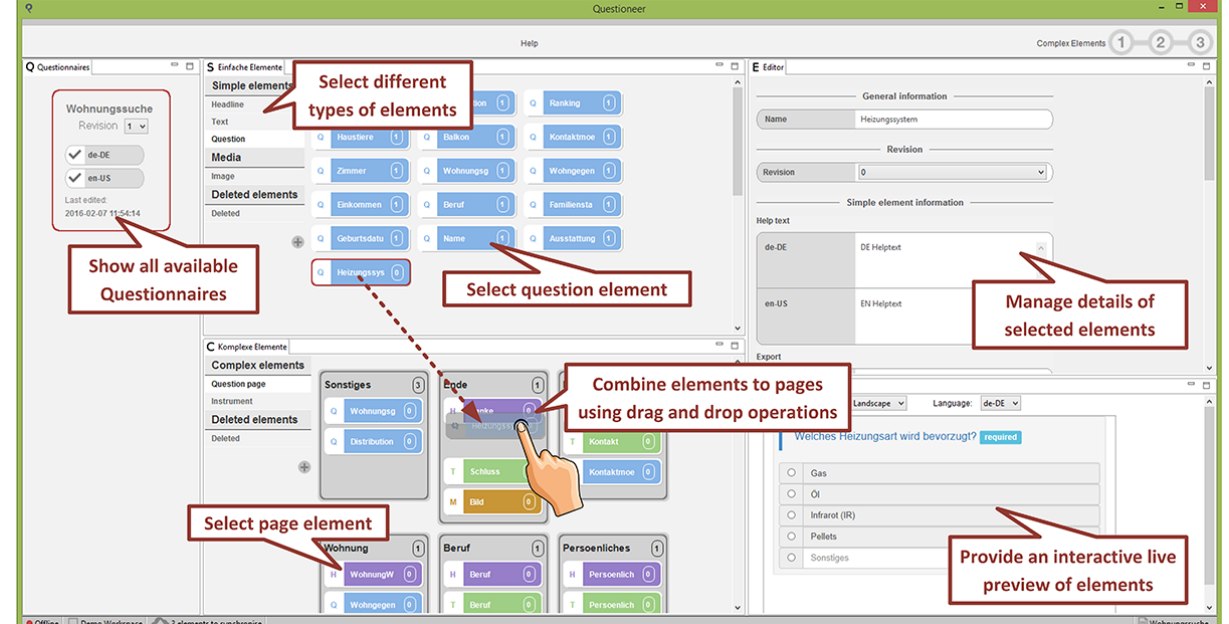
Figure 2. The QuestionSys configurator: combining elements to